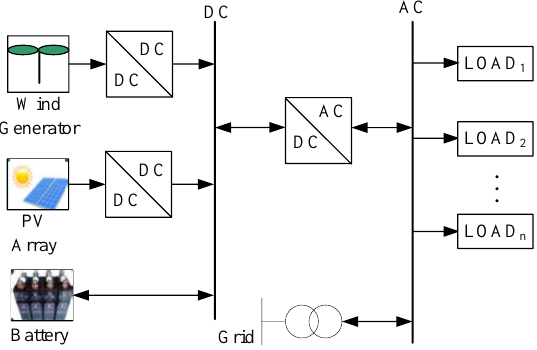
Figure 1. Schematic of the microgrid.